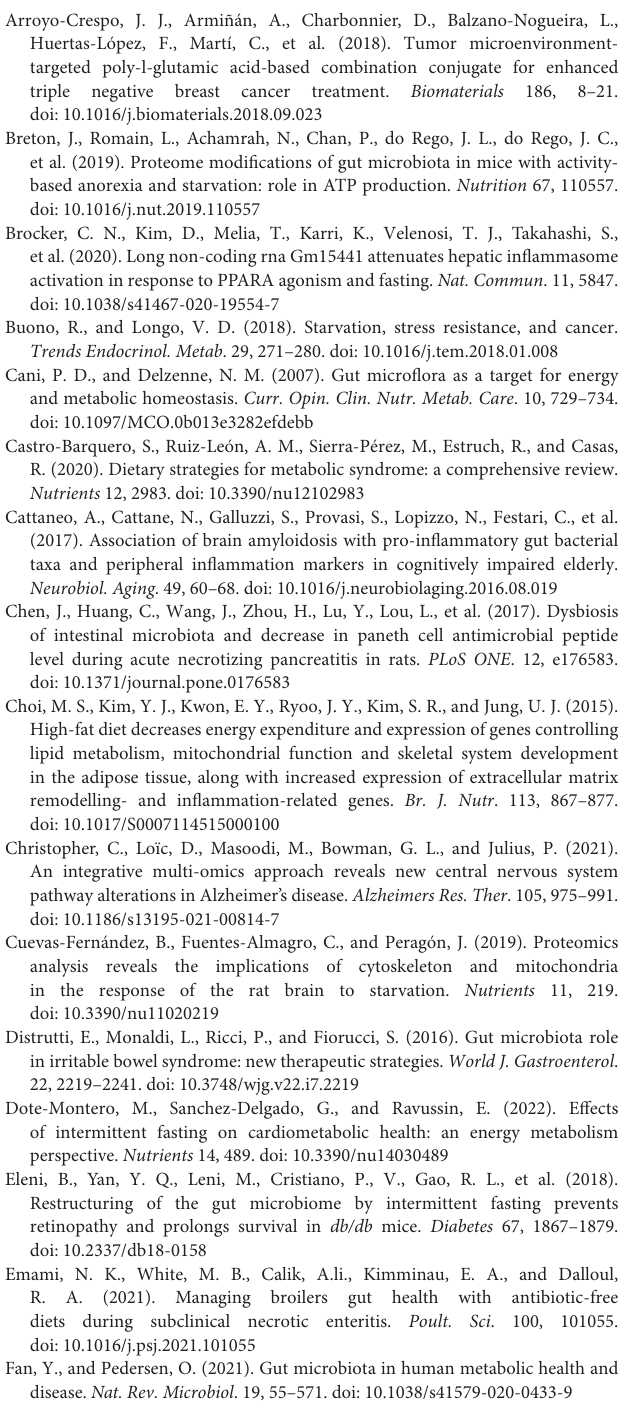
Supplementary Table S12 | Metabolites detected in the negative-ion